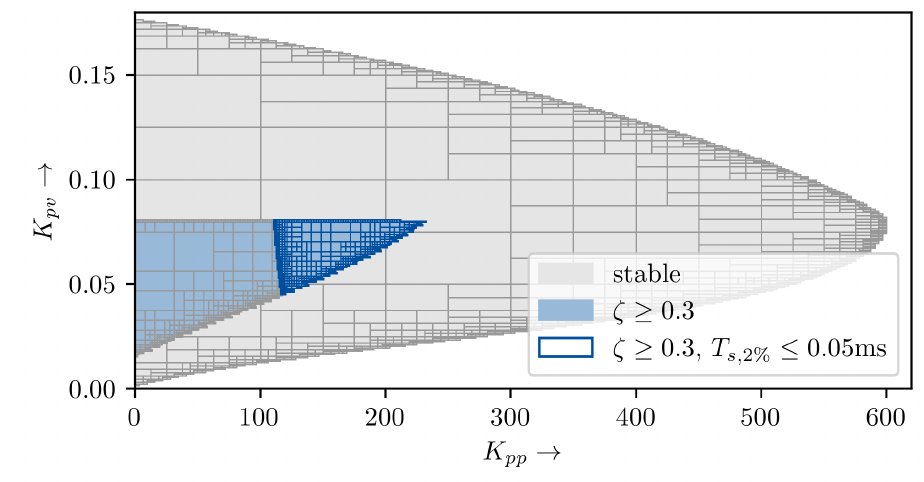
Figure 12. SIVIA result for an interval system with b 0 ∈ [ 0.95 · 10 4 , 1.05 · 10 4 ] , T d = 0.7 ms and different requirements for settling time and damping